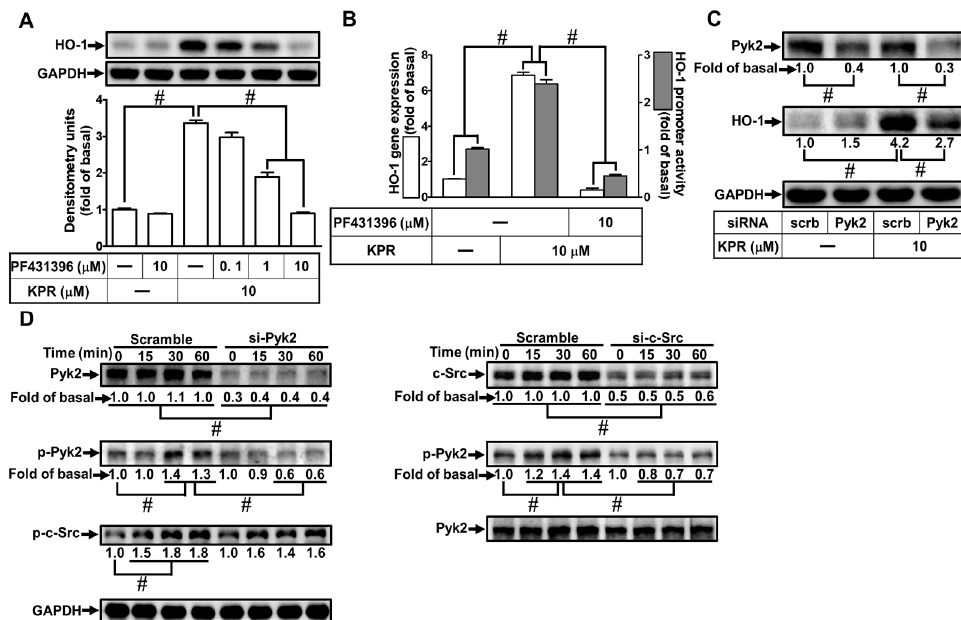
Figure 6. Pyk2 involves in KPR-induced HO-1 expression. ( A ) HPAEpiCs were pretreated with various concentrations of PF431396 for 1 h and then incubated with DMSO or KPR (10 µ M) for 16 h. The protein expression of HO-1 was determined by Western blot using GAPDH as a loading control. ( B ) Cells were pretreated with or without PF431396 (10 µ M) for 1 h and then incubated with DMSO or KPR (10 µ M) for the indicated time intervals. The HO-1 mRNA expression and promoter activity were analyzed by real-time PCR (6 h) and promoter activity assay (8 h), respectively. ( C ) Cells were transfected with scrambled (scrb) or Pyk2 siRNA, and then incubated with KPR (10 µ M) for 16 h. The protein level of HO-1, Pyk2, and GAPDH was determined by Western blot. ( D ) Cells were transfected with c-Src or Pyk2 siRNA, and then incubated with KPR (10 µ M) for the indicated time intervals.